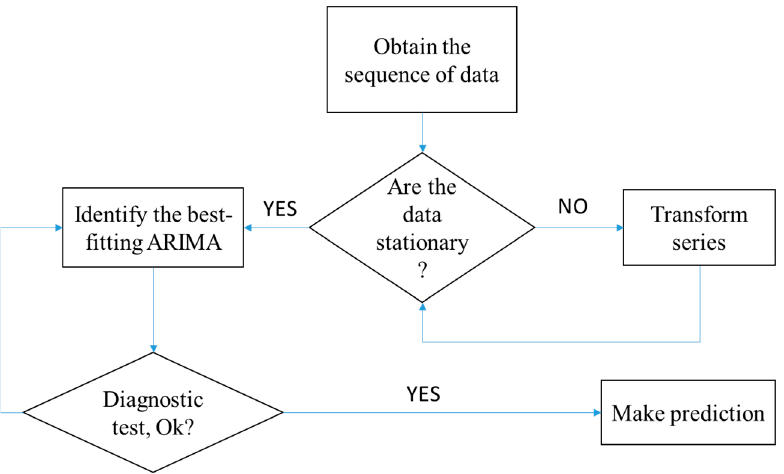
Figure 1. Flowchart of the autoregressive integrated moving average (ARIMA) model [41].